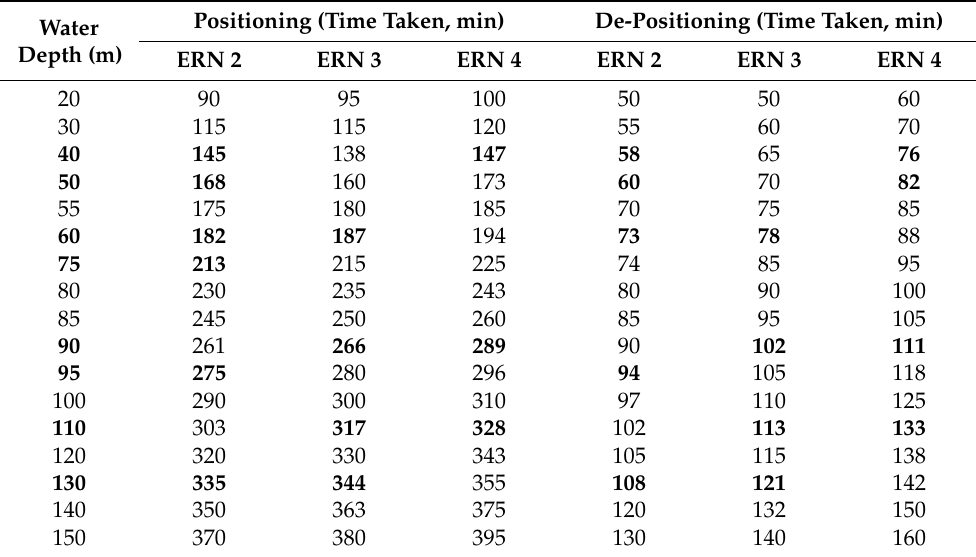
Table 9. Time taken for SM system positioning and de-positioning at various depth and ERN. Water Depth (m)